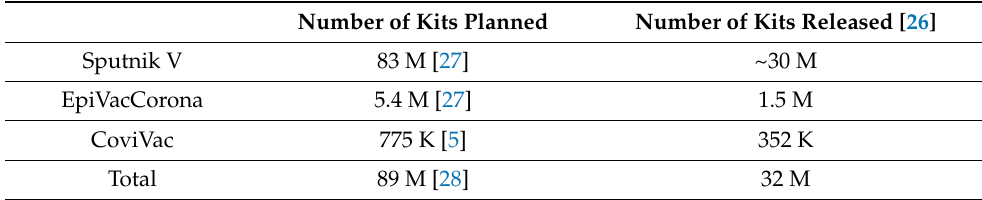
Table 1. Comparison between the vaccine production targets for the end of June 2021 and the actual number of kits produced by the end of June